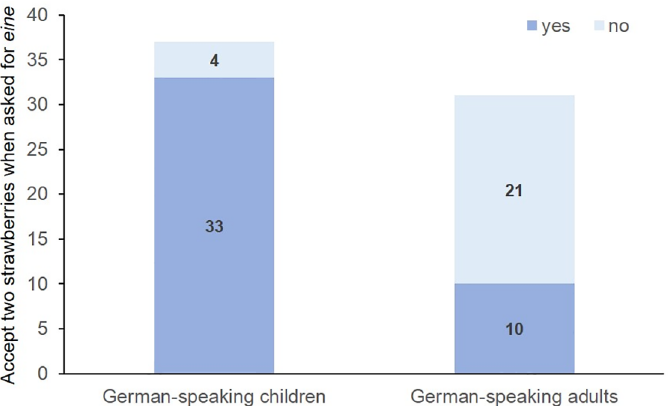
Figure 1. Number of German-speaking adults and children who accepted or rejected two strawberries as a response to eine during the critical trial (i.e., when two strawberries were